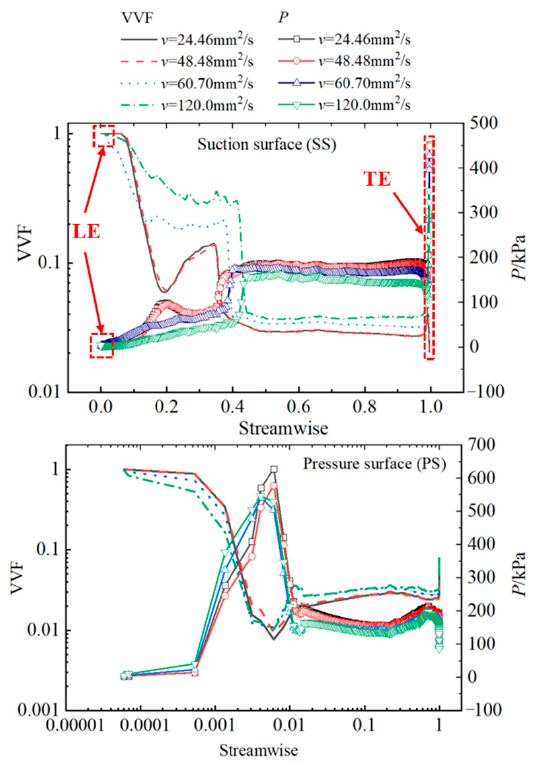
Figure 10. VVF and pressure distribution on suction surface (SS) and pressure surface (PS) along the blade streamline at 0.5 times blade height ( Δ = 3%).